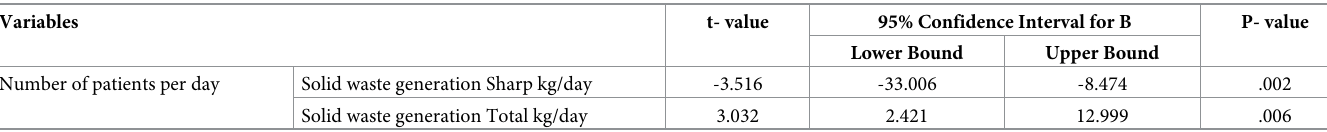
Table 7. Linear regression analysis of the association of number of patients per day with total generation of solid biomedical waste in medical laboratories. Variables